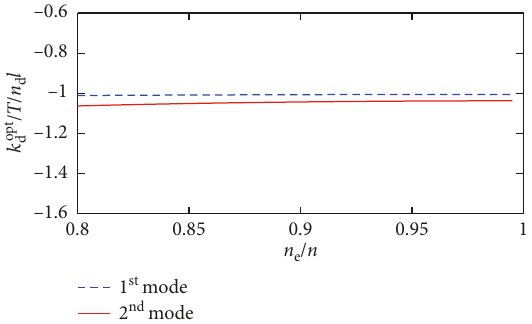
Figure 9: Change trend of the optimal negative stiffness to the excitation position.